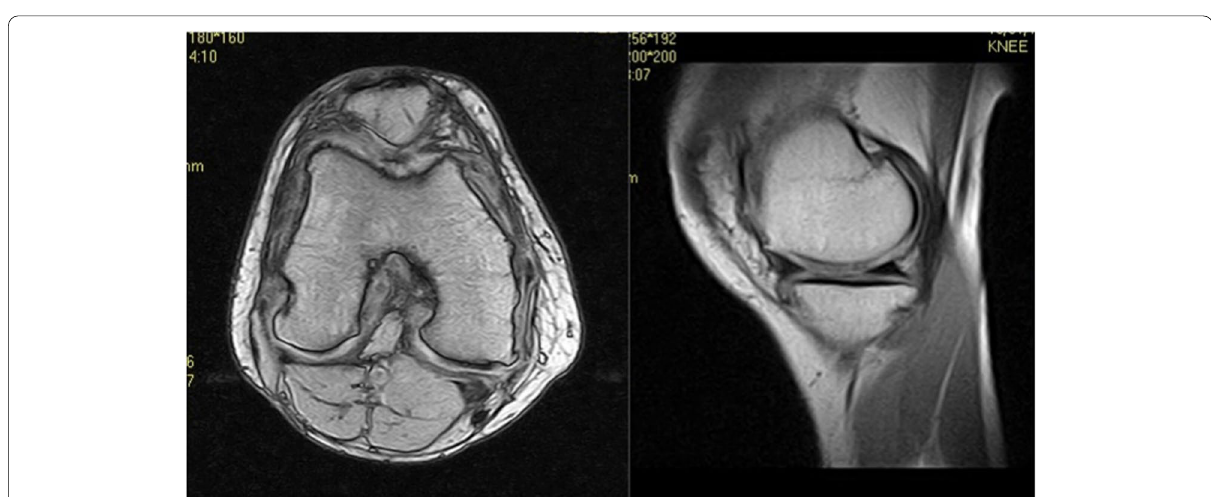
Fig. 8 Patient MRI with a grade 4 cartilage lesion in the trochlea, patella and medial femoral condyle. 395